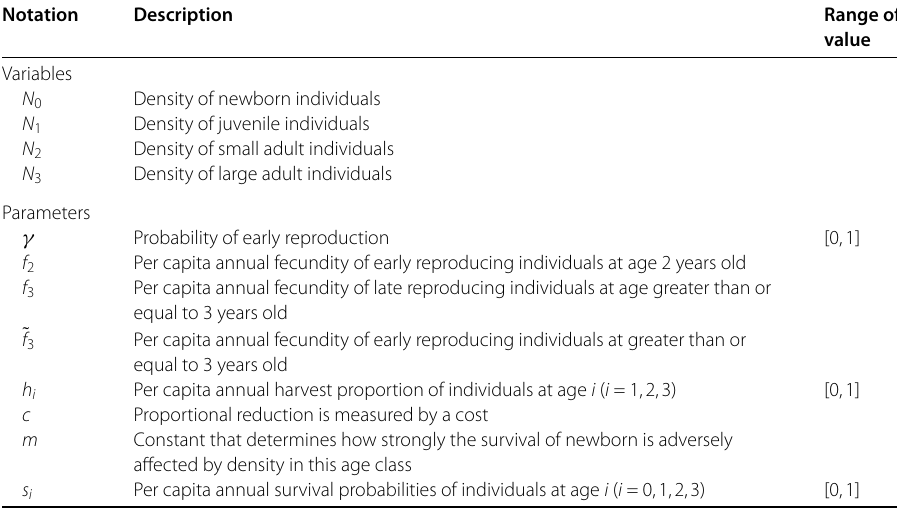
Table 1 Definition of model variables and parameters, adapted from